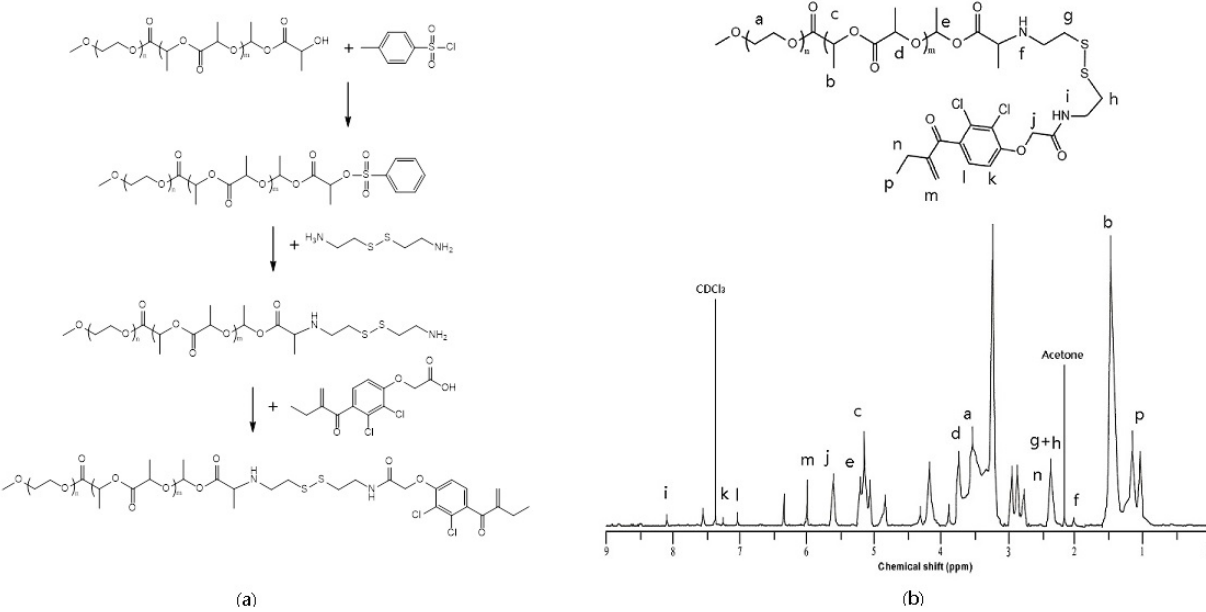
Figure 1. ( a ) Synthesis of the polymer conjugates of ethacrynic acid (ECA); ( b ) 1 H NMR (Proton Nuclear Magnetic Resonance Test) spectra of polymer conjugate ECA inCDCl 3